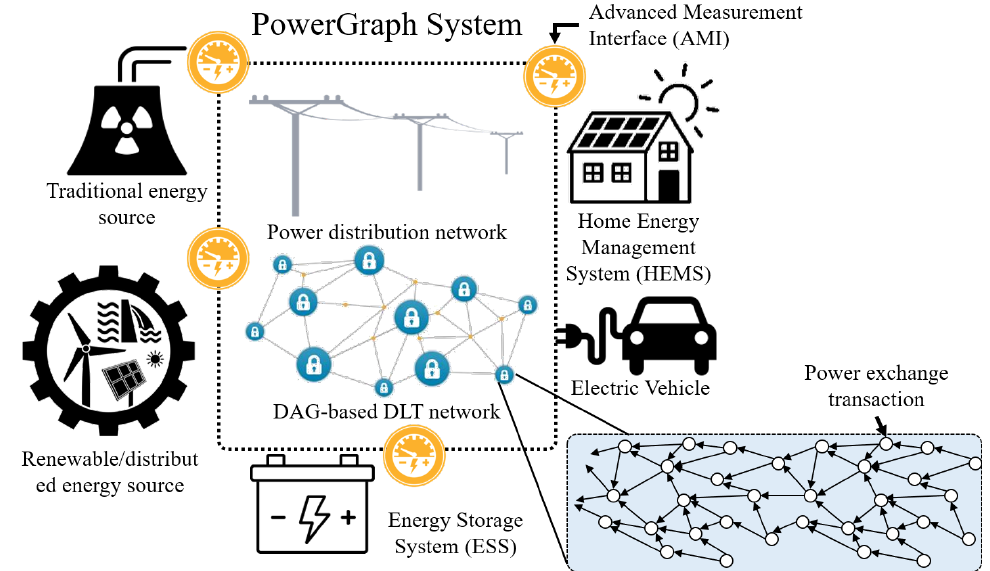
Figure 1. PowerGraph